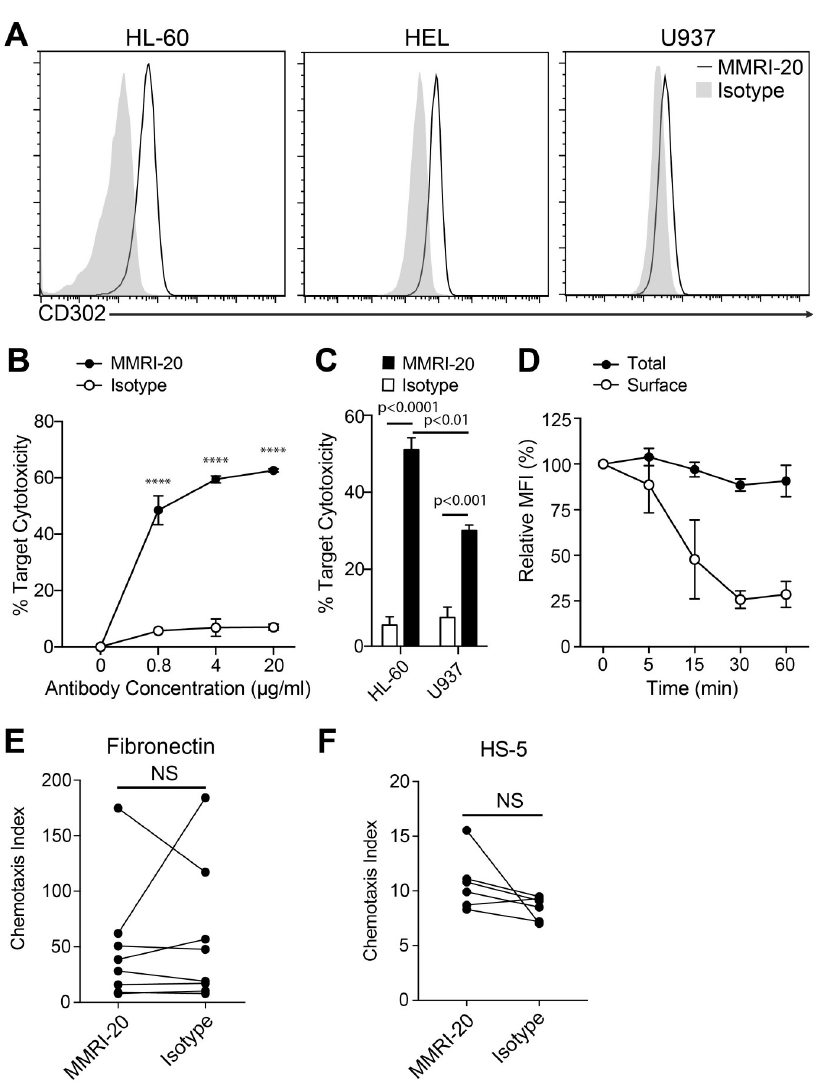
Fig 2. Antibodies targeting CD302 are able to be internalised and mediate ADCC of target cells. (A) Flow cytometry histograms showing the surface expression of CD302 on leukemic target cell lines as determined by staining with the MMRI-20 compared to a mouse IgG1 isotype control. (B) CD302 internalisation by HL-60 cells determined by flow cytometry. Total staining determined by MMRI-20-FITC 37˚C incubation for the indicated times after which residual surface CD302 was measured with anti-mouse IgG-PE at 4˚C. MFI of antibody staining is reported relative to pre-incubation levels. (C) MMRI-20 induced ADCC against HL-60 target cells. Calcein-AM labelled HL-60 were incubated for 18h with mouse spleen effectors at a 1:10 ratio, together with1000U IL-2 and the indicated concentrations of MMRI-20 or isotype control mAb. Target cell killing was measured as 7-AAD + Calcein-AM + cells by flow cytometry and presented relative to death in target alone (0%) or with 2% Triton X solution (100%). ���� p < 0.0001, two-way ANOVA. (D) ADCC elicited against HL-60 (CD302 hi ) and U937 (CD302 lo ) leukemic targets using 20 μ g/ml MMRI-20 or isotype mAb control. Experiments representative of three experiments. Differences tested by two-way ANOVA. (E-F) HL-60 cells were incubated with either MMRI-20 or isotype control mAb for 30 mins at 37˚C and tested for their ability to migrate across 5 μ m transwells coated with (E) fibronectin or (F) HS-5 cells towards 160 ng/ml CXCL12 or media alone. Cells in bottom chamber were enumerated after 4h by using flow cytometry and migration presented as the chemotaxis index. Circles connected by lines represent individual paired experiments. No significant difference (NS) between MMRI-20 and isotype group (paired t-test).